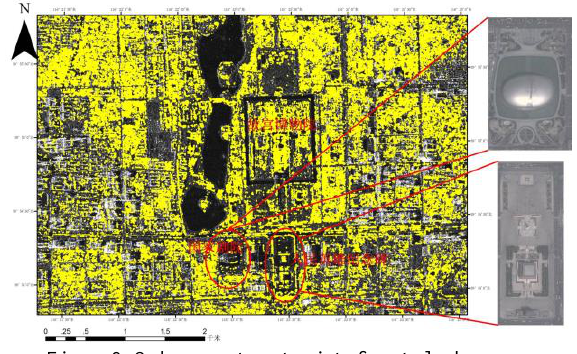
Figure 9. Coherence target point of central urban area Select the central urban area of Beijing to show the high coherence target poin(Figure 9). Because of the high building stability in Beijing central area, the scattering characteristics of these targets have remained almost constant over time, even if the threshold is set to 0.5, a large number of high coherence points can be obtained.